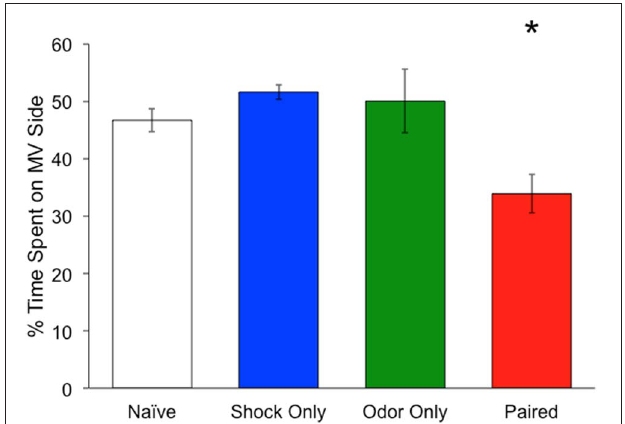
FIGURE 1 | Mean time spent on methyl valerate side of a two-odor choice test. Mice were either exposed to pairings of methyl valerate (MV) + foot shock (red) ( n = 10), foot shock only (blue) ( n = 6), odor only (green) ( n = 6), or neither (white) ( n = 4). Each animal spent a total of 180s in the chamber. Mice exposed to MV + foot shock spent significantly less time on the methyl valerate side as compared to the other groups. ∗ Denotes a significant difference between the groups ( p < 0 . 05). Error bars represent